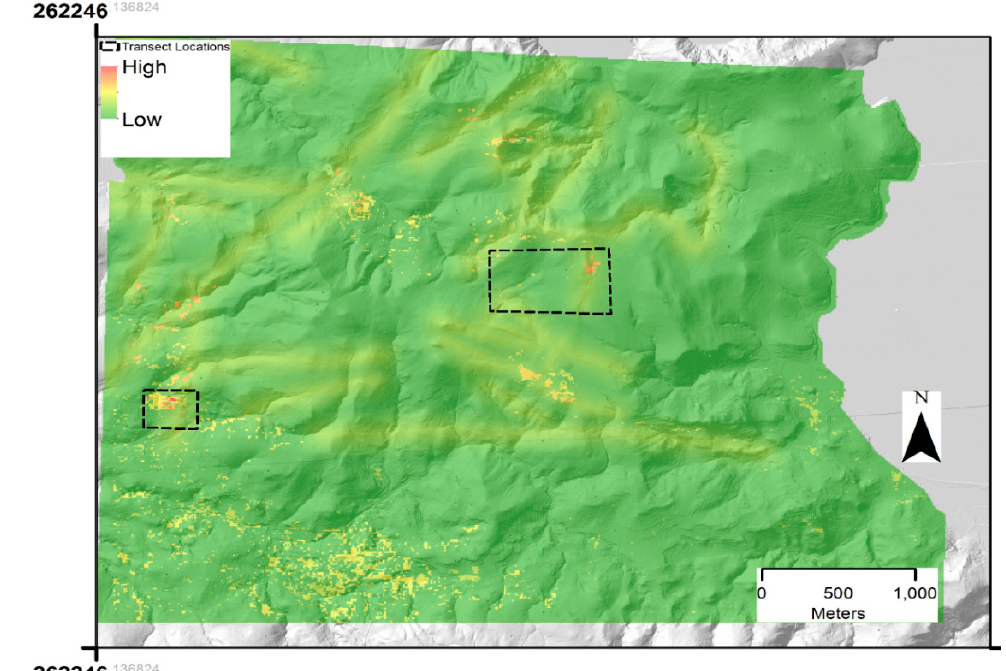
Figure 7. Results of mineral prospectivity mapping (MPM) modelling superimposed on a Digital Elevation Model. The level of modelled mineral prospectivity is scaled from low (green) to high (red) values.